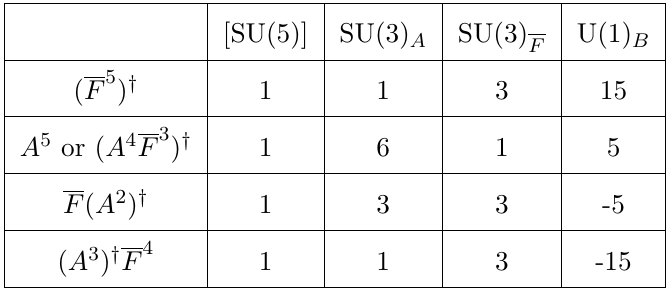
Table 3 . A second possible solution to the anomaly matching conditions. Note that the F 5 state requires an orbital angular momentum among the